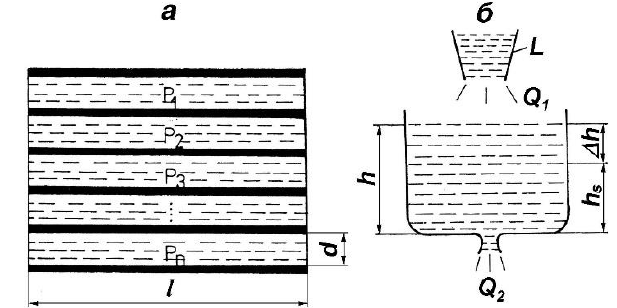
Figure 1. Stylized scheme of oscillatory transporting platform (1-platform; 2-suspension; 3-excenter; 4-driving lever; А- amplitude of oscillation of the platform (radius of the excenter);  - phase of platform oscillation;  ,  ,  - influential angles of the platform; А, B, C, D-supporting points of the platform).